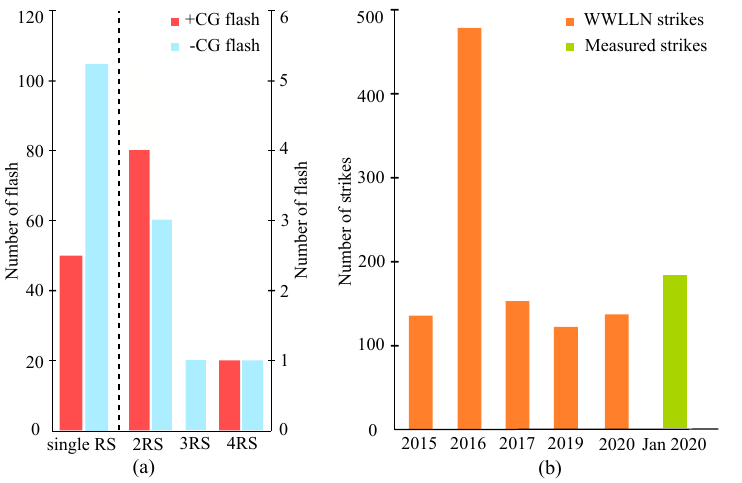
Figure 2. ( a ) Distribution of CG flashes recorded in Antarctica based on its polarities; ( b ) total number of lightning strikes; orange represents worldwide lightning location network (WWLLN) annual lightning strikes distribution between 2015 and 2020, while the green column represents total CG lightning strokes in King Sejong Station recorded by our lightning measurement station between 11 and 31 January 2020 in Antarctica. Figure 3 shows the locations of the return strokes of +CG (red plots) and − CG (blue plots) flashes located between 32 and 530 km and between 32 and 569 km, respectively. A